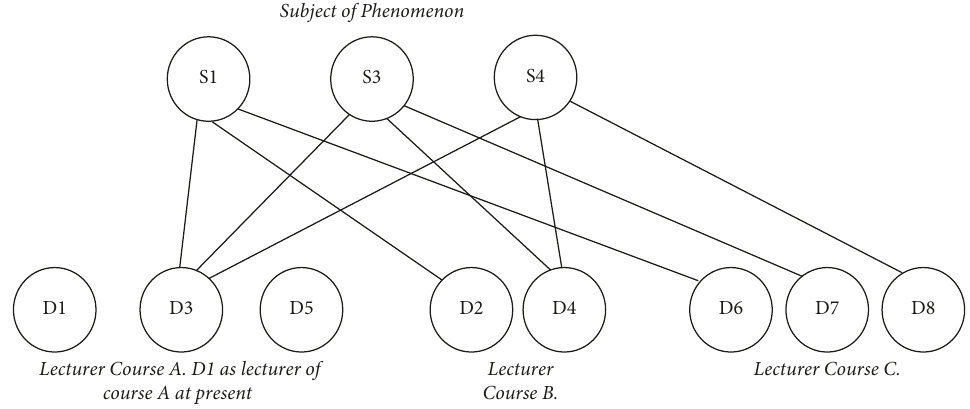
Figure 2: Subject search scheme for this study.